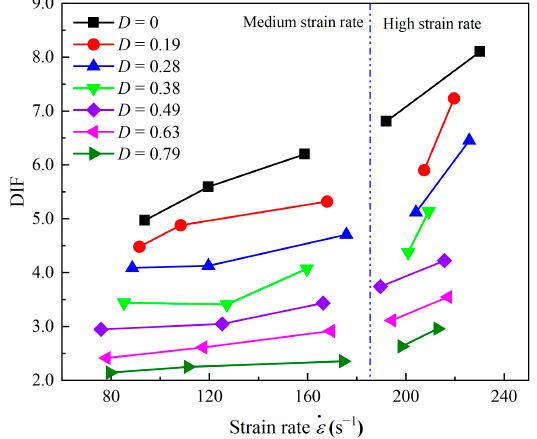
Figure 20. Dynamic increase factor (DIF) of the deformation modulus.